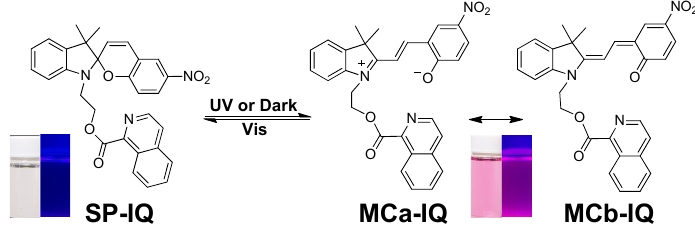
SP-IQ MCb-IQMCa-IQ Scheme 2. Interconversion between SP-IQ and MC-IQ . MC-IQ is a resonance hybrid between MCa- IQ and MCb-IQ . In each pair of photos, left and right show the color and fluorescence of the solution, respectively.